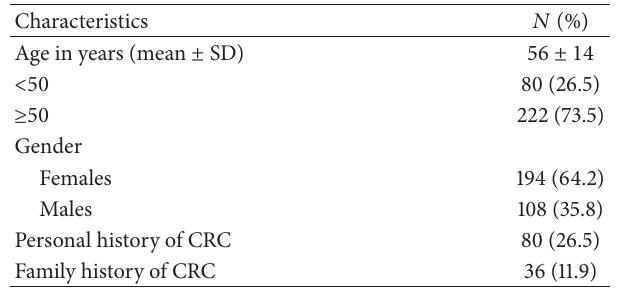
Table 1: Demographic characteristics of the study